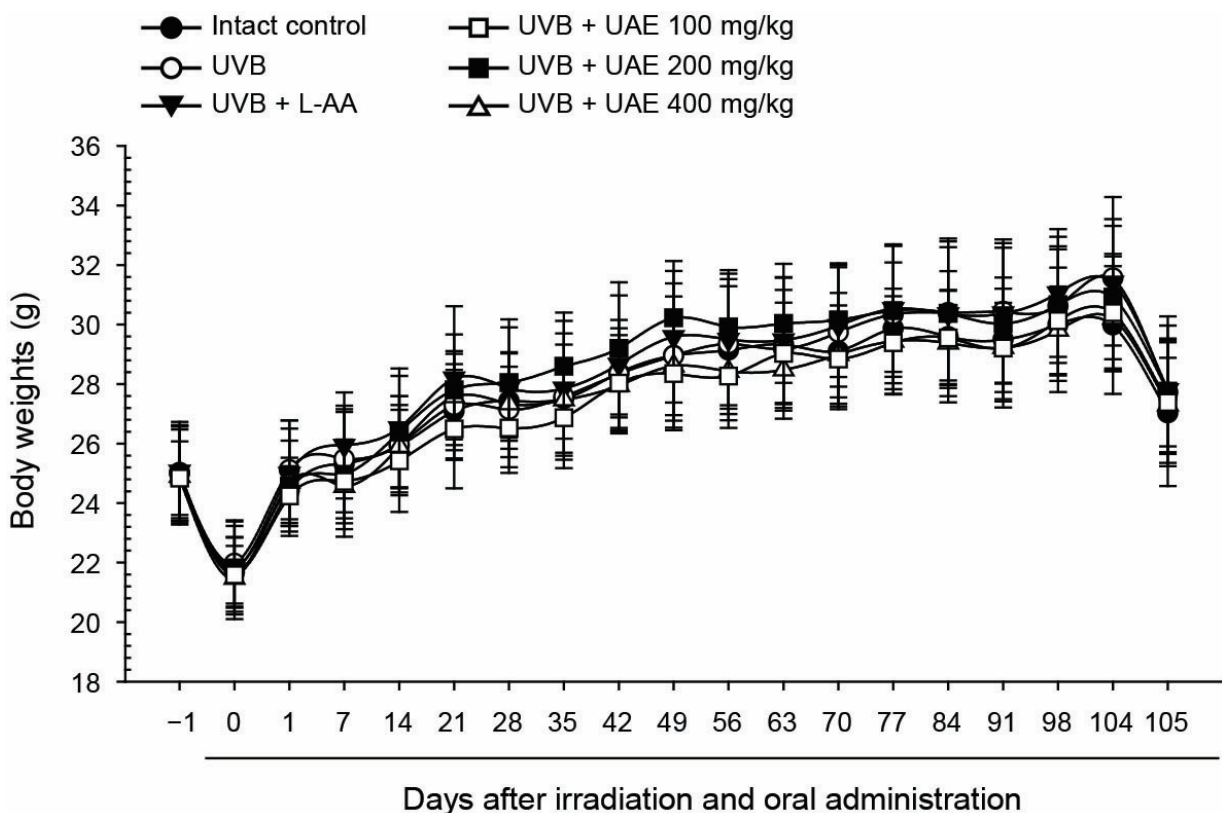
Figure 1. Bodyweight changes on the days after UVB irradiation and oral administration. The mice were irradiated to UVB (three times per week) or not for 15 weeks. UAE (100, 200, and 400 mg/kg) or L-AA (100 mg/kg) was orally administrated once a day for 105 days after 1 h of UVB irradiation. All mice were overnight fasted prior to both first administration and sacrifice. The body weights were measured every week. Data are represented as mean ± SD (n = 10, significance compared with intact control mice).